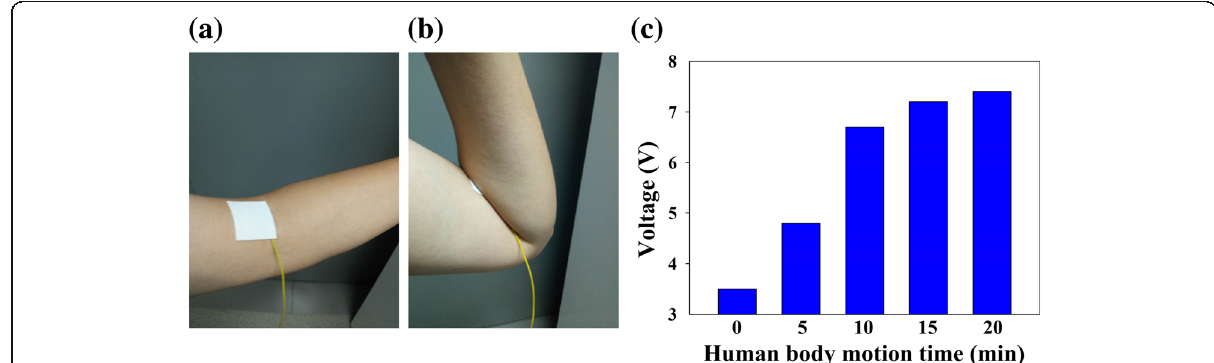
Fig. 6 The a , b working pattern for harvesting human elbow motion energy, c electronic output (subject to a corresponding load of 100 M Ω ) versus human motion